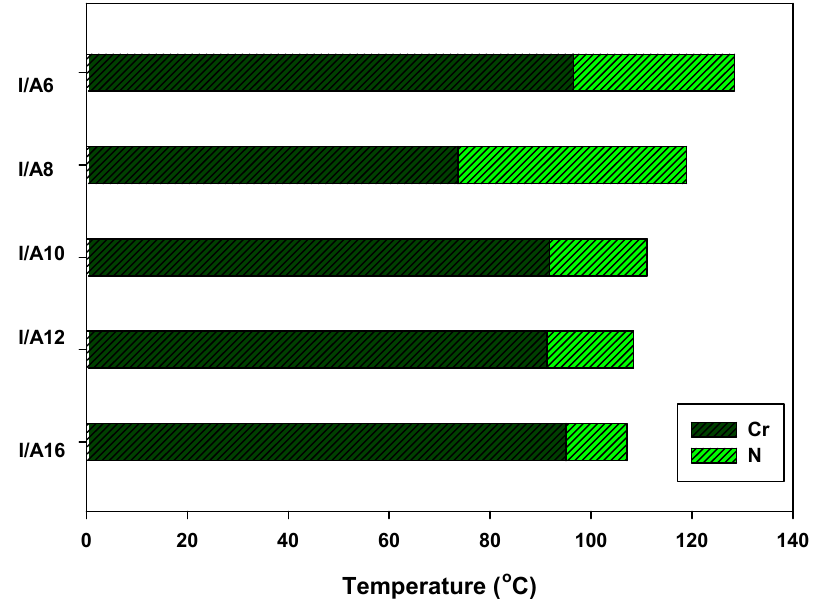
Figure 2. Graphical DSC transitions of supramolecular H-bonded complexes I / An upon second heating cycle.